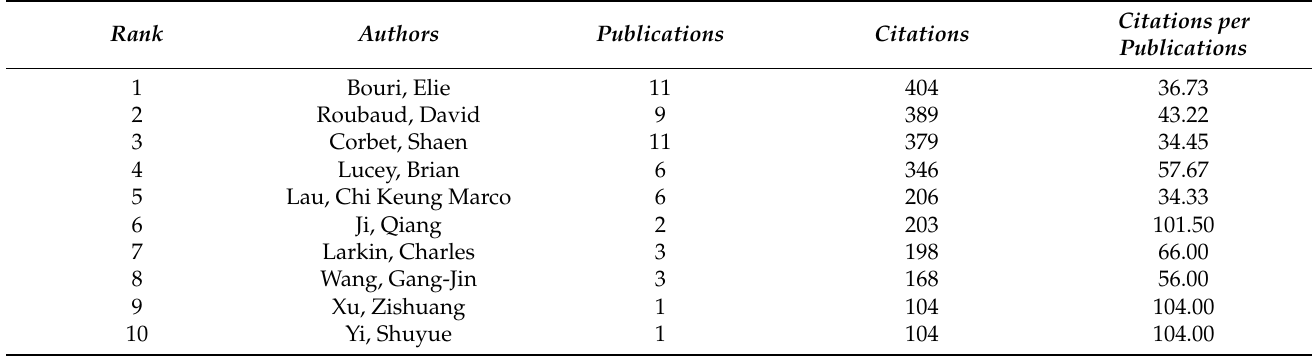
Table 2. Top 10 authors by number of citations.